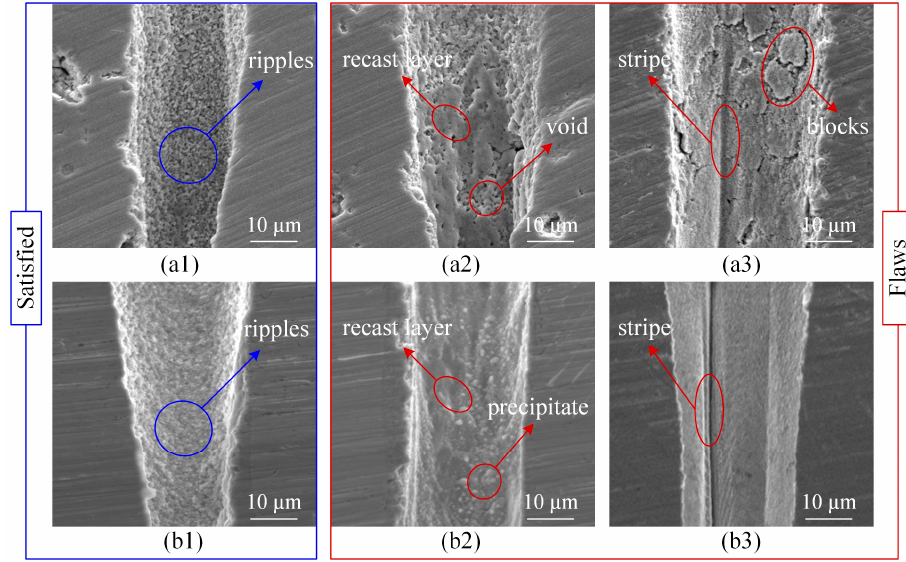
Figure 8. SEM images of typical morphological features on the holes side-walls surfaces. ( a1 – a3 ):